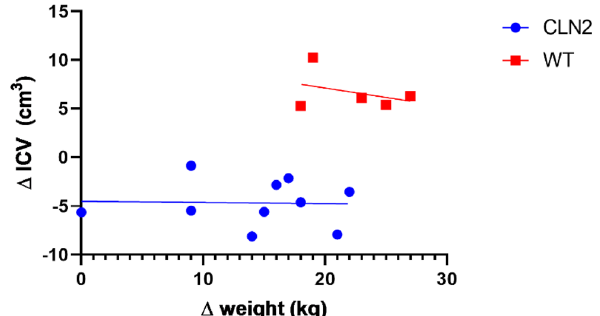
Figure 2. The relationship between weight change (17–12 months) and change in intracranial volume (ICV) (17–12 months) in the CLN2 R208X/R208X miniswine (blue, R 2 = 0.0011) and WT miniswine (red, R 2 = 0.13), showing reduction in ICV (volume change range: − 1 to − 8 cm 3 ) across CLN2 R208X/R208X miniswine unrelated to the large variation in weight change across the cohort (0 to 22